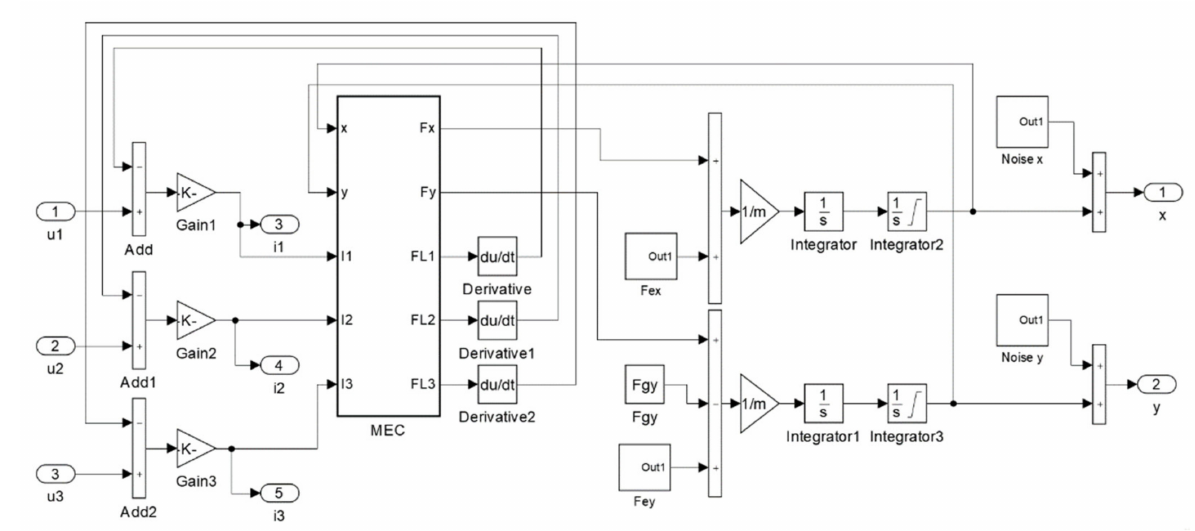
Figure 3. Implementation of the flux-circuit directly coupled magnetic equivalent